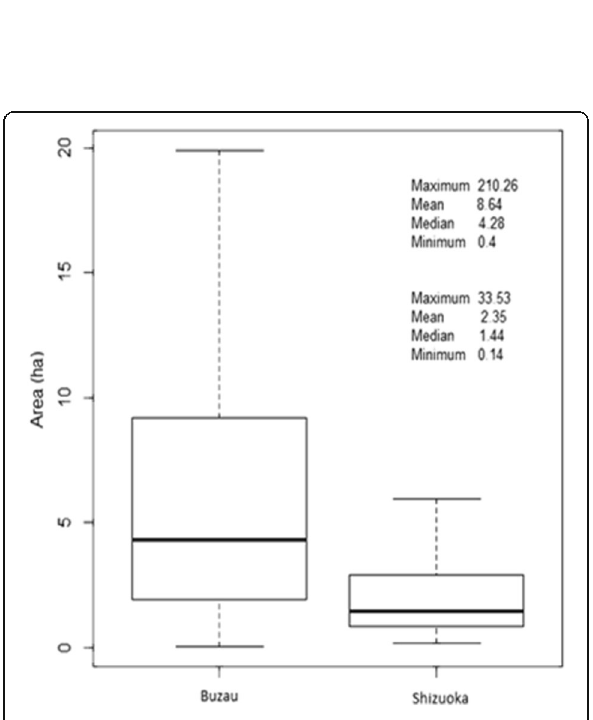
Fig. 3 Area of landslide scarps in the two study areas, in hectares. Boxplots represent 25 – 75% of values, whiskers represent 10 – 90% of values, and the line within the box represents the median. Extreme values are omitted